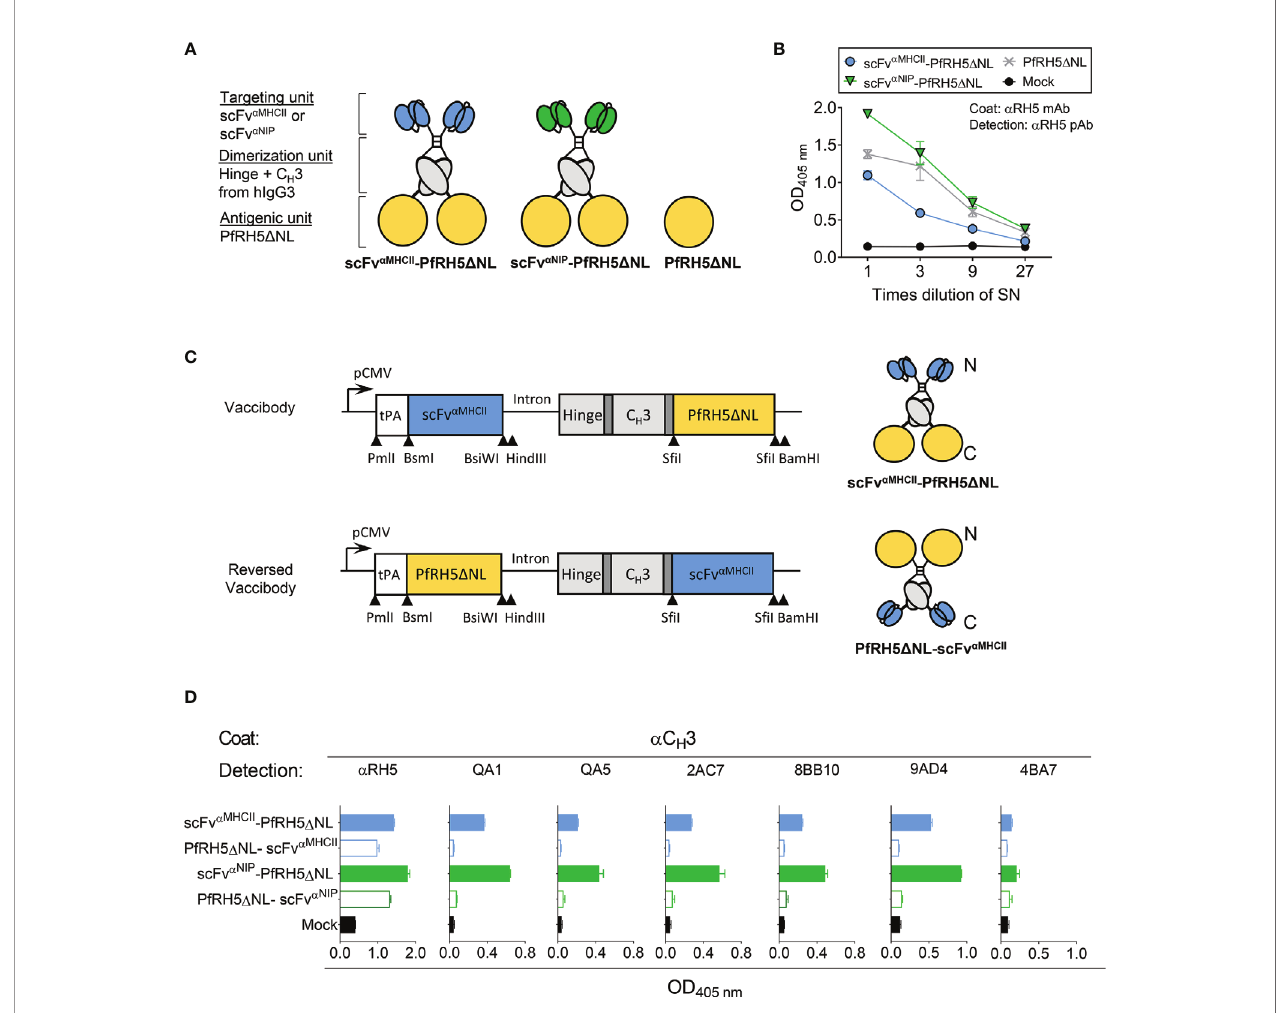
FIGURE 1 | Characterization of APC-targeted malarial DNA vaccines and translation into vaccine proteins. (A) Schematic representation of dimeric Vaccibody proteins. Each chain of the dimer was composed of a targeting unit consisting of a scFv that binds MHC class II (scFv a MHCII , blue) molecules on APCs or a non- targeted control (scFv a NIP , green), a dimerization unit (grey) composed of a shortened Ig hinge and CH3 domain from human g 3 chains, and the truncated PfRH5 D NL as the antigenic unit (yellow). In addition, a vaccine plasmid only expressing the PfRH5 D NL was included. (B) HEK293E cells were transiently transfected with DNA plasmids as indicated, and vaccine proteins containing PfRH5 D NL in the supernatants (SN) were detected by sandwich ELISA. (C) In the conventional Vaccibody (upper right), the antigenic unit was coupled at the C-terminal end of the fusion protein. Whereas for the reversed Vaccibody (lower right), the antigenic unit was linked N-terminally to the dimerization unit. The DNA vaccine plasmids (left, upper and lower construct) contain a promoter (pCMV), a tPA leader peptide (white box) and short linkers (dark grey) that increase the fl exibility of the various units. Unique restriction enzyme sites for cloning are indicated. (D) PfRH5 D NL expressed as targeted or non-targeted vaccines either as a C-terminal fusion (conventional Vaccibody) or N-terminal fusion (reversed Vaccibody) in HEK293E cells, and detected with a PfRH5 pAb or various unique anti-PfRH5 mAbs. Data shown are mean ±